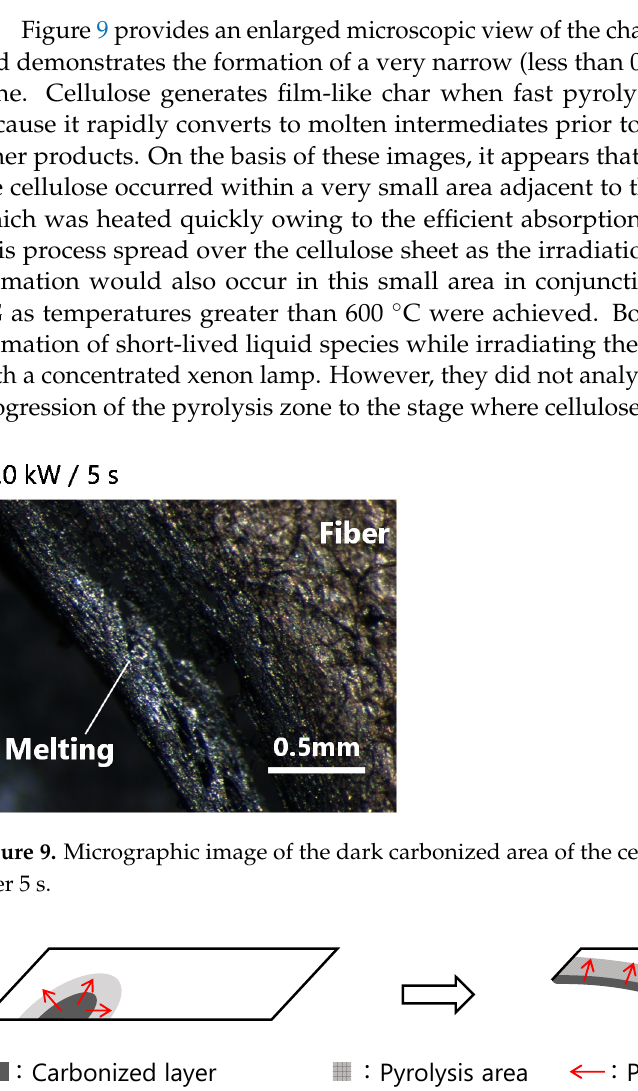
Figure 8. Photographic images of cellulose chars obtained under various fast pyrolysis conditions.